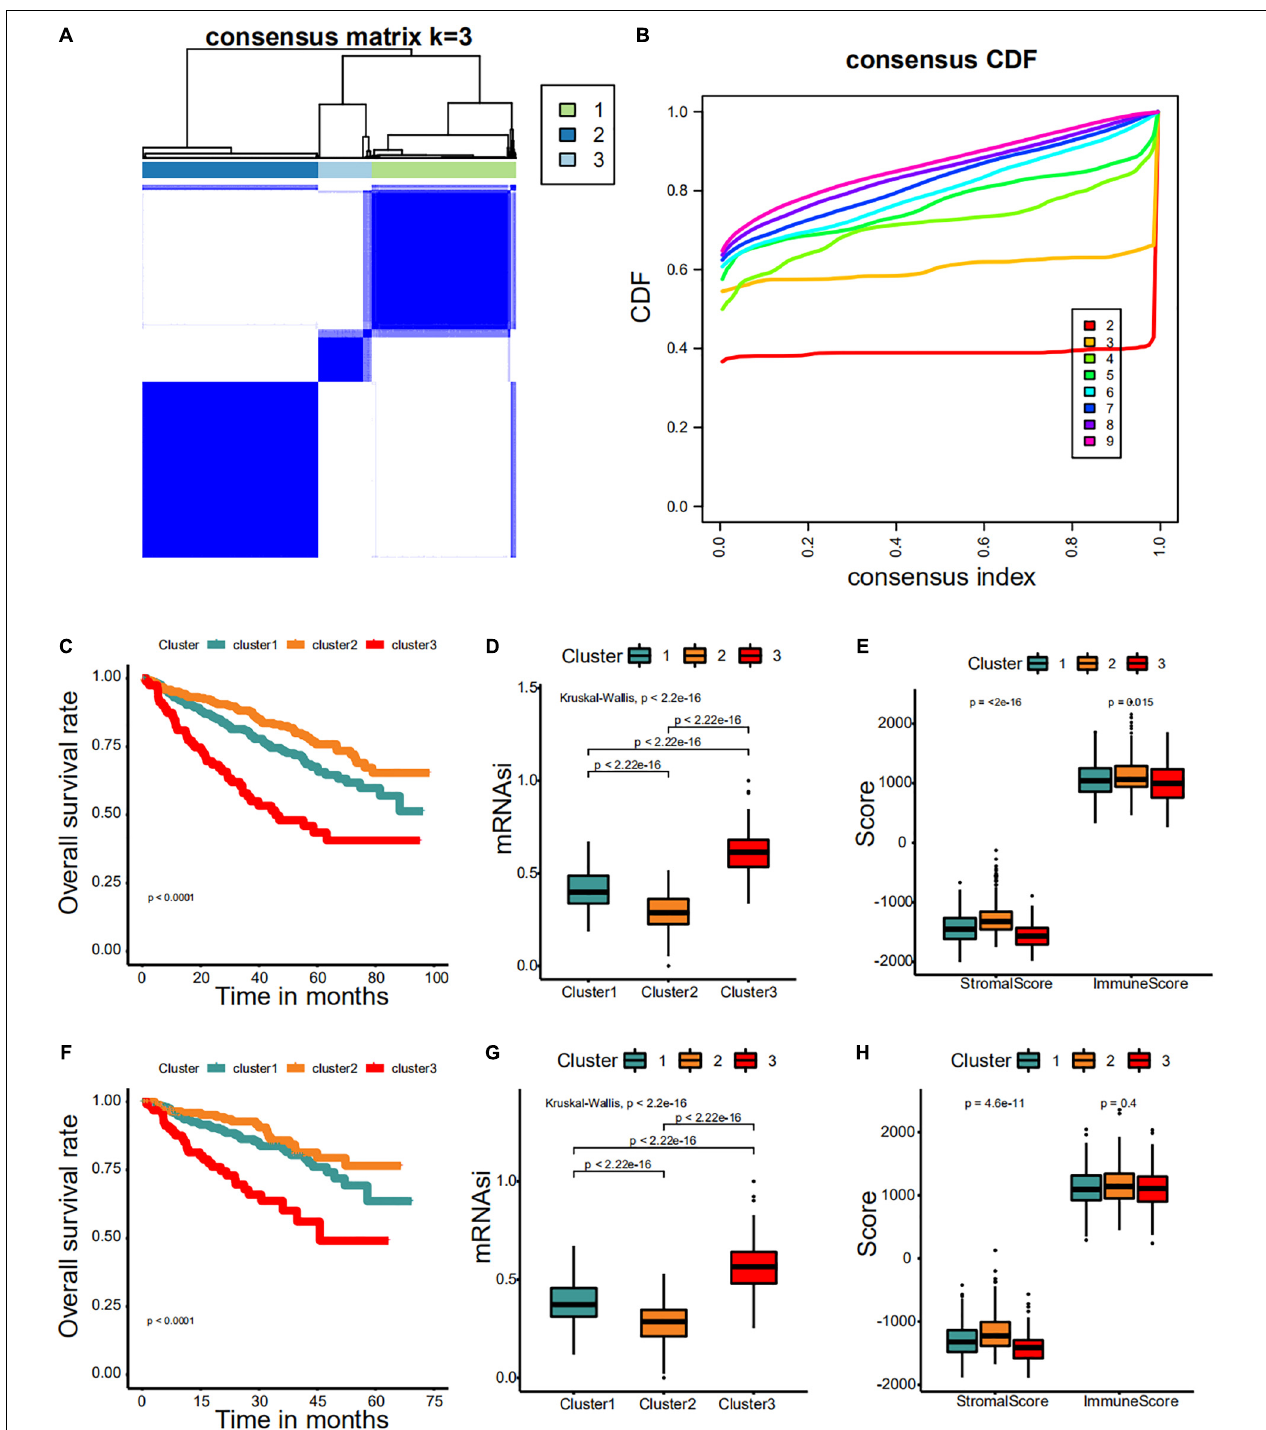
FIGURE 8 | Consensus clustering identified distinct multiple myeloma stemness (MMS) clusters with different prognoses. (A) Consensus score matrix for MM samples when k = 3. (B) The cumulative distribution function (CDF) describes a real random variable of its probability distribution based on consensus scores for different subtype numbers ( k = 2–9). (C) The Kaplan–Meier curve was used to determine the OS of patients of different MMS clusters in the GSE24080 cohort. (D) Difference in mRNAsi among distinct MMS clusters in patients of the GSE24080 cohort. (E) Difference in stromalscore and immunescore among distinct MMS clusters in patients of the GSE24080 cohort. (F) The Kaplan–Meier curve was used to determine the OS of patients of different MMS clusters in the GSE4204 cohort. (G) Difference in mRNAsi among distinct MMS clusters in patients of the GSE4204 cohort. (H) Difference in stromalscore and immunescore among distinct MMS clusters in patients of the GSE4204